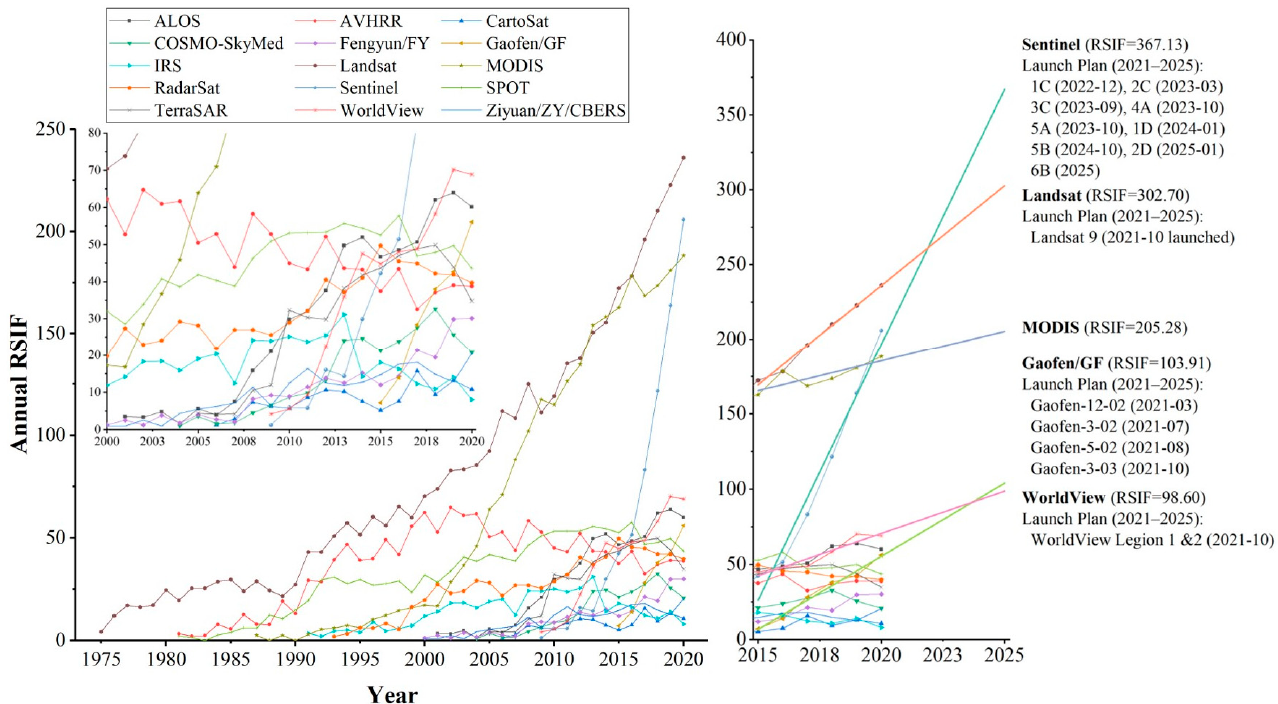
Figure 3. Annual RSIF for Earth observation satellites (the graphic inside is a zoom of dense area, and the right figure is the result based on the linear extrapolation).